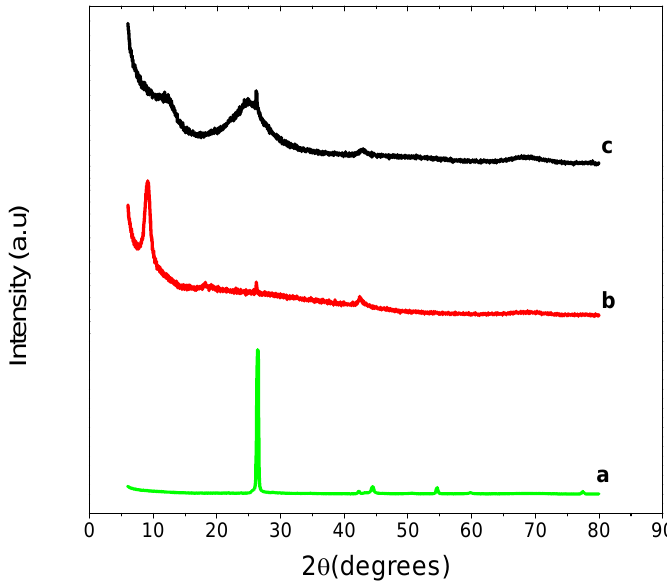
Figure 2. XRD patterns of graphite (curve a ), graphite oxide (curve b ) and graphene (curve c ).